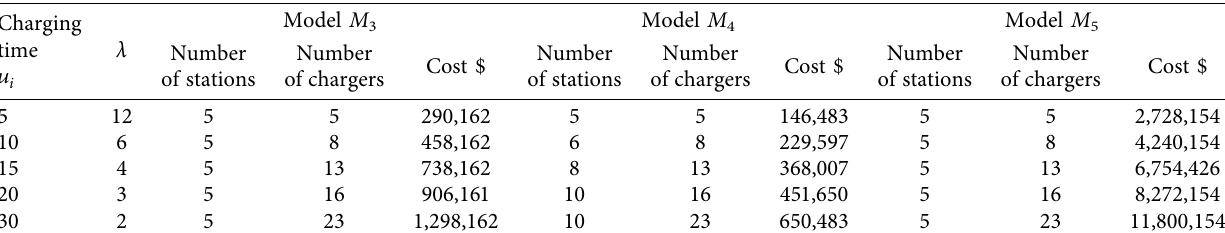
Table 6: Efect of the EVs’ charger costs on M